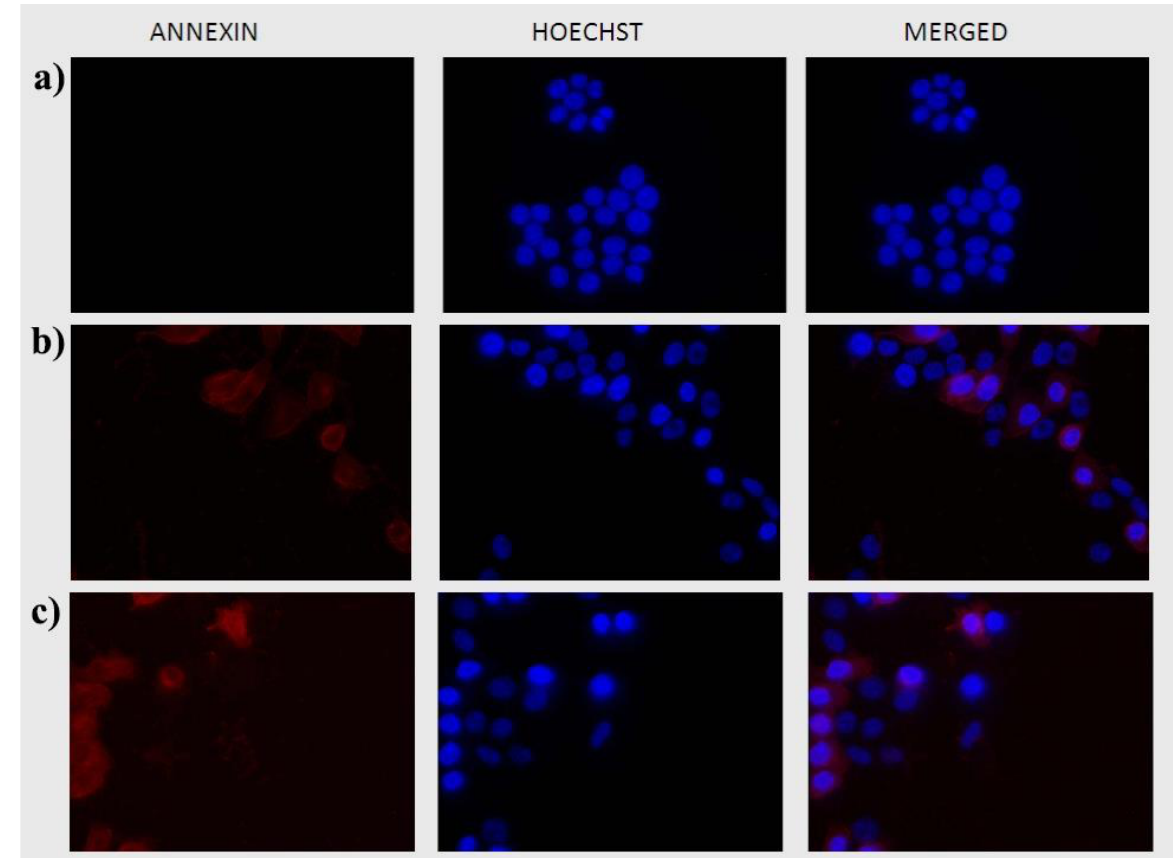
Figure 5. Morphology of HeLa cells with Annexin – Hoechst staining; ( a ) Untreated cells, ( b , c ) HeLa cells treated with OIM 50 and 100 µg/mL, respectively.